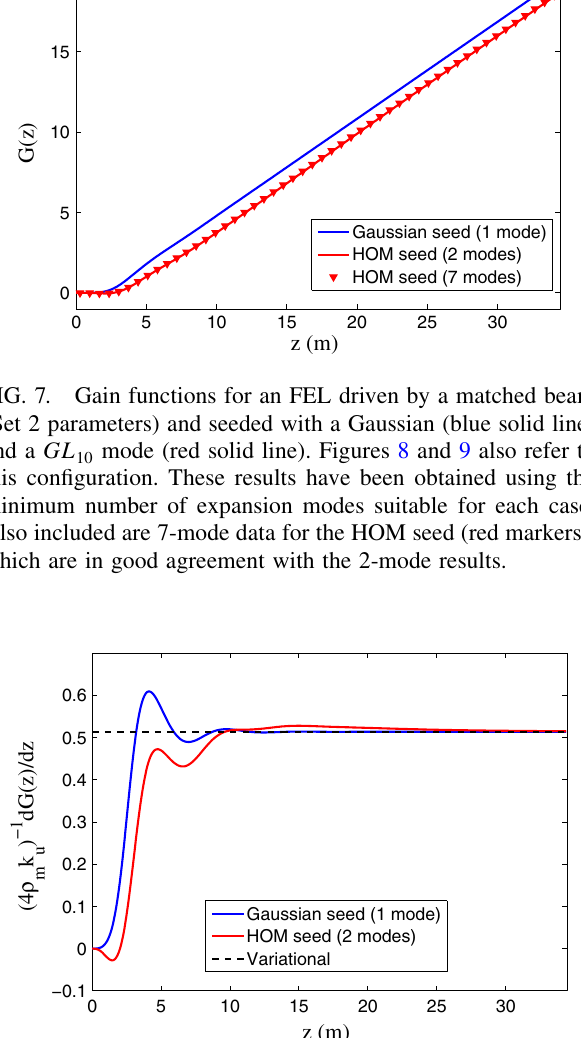
FIG. 9. Amplitude ratios r versus z . The plots were generated using the 2-mode results for the case of the GL